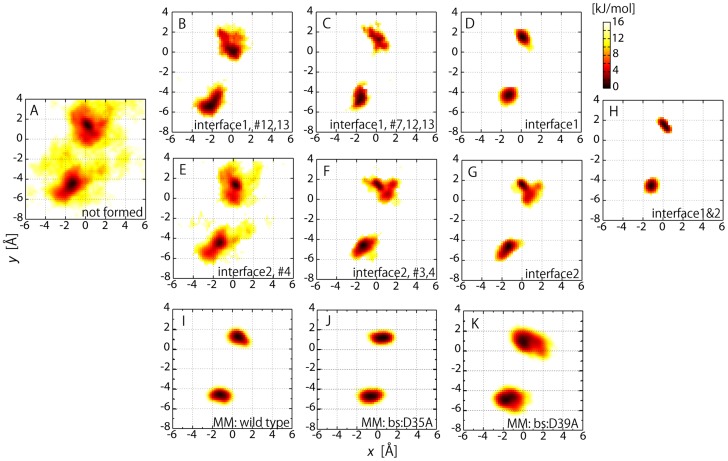
Free energy surfaces for two localized interfaces.2-D free energy surfaces of barstar position on x-y plane of barnase: Two distributions are plotted on same figure for centers of mass of barstar residues comprising interface 1 (Tyr29, Asn33, and Asp39: upper right) and that for interface 2 (Asp35 and Glu76: lower left). In A–H, the distributions are drawn for the unbiased MSES ensemble under the respective conditions that the polar contacts given at the bottom (the identifier defined in Table 1) are formed. “Interface 1”, “interface 2”, and “interfaces 1&2” indicate the structures when all the polar contacts in interface 1 and/or 2 are formed, respectively. In I–K, the distributions obtained in the MM simulations starting from the complex structure are shown for the wild type (I) and the two mutants, bs:D35A (J) and bs:D39A (K).